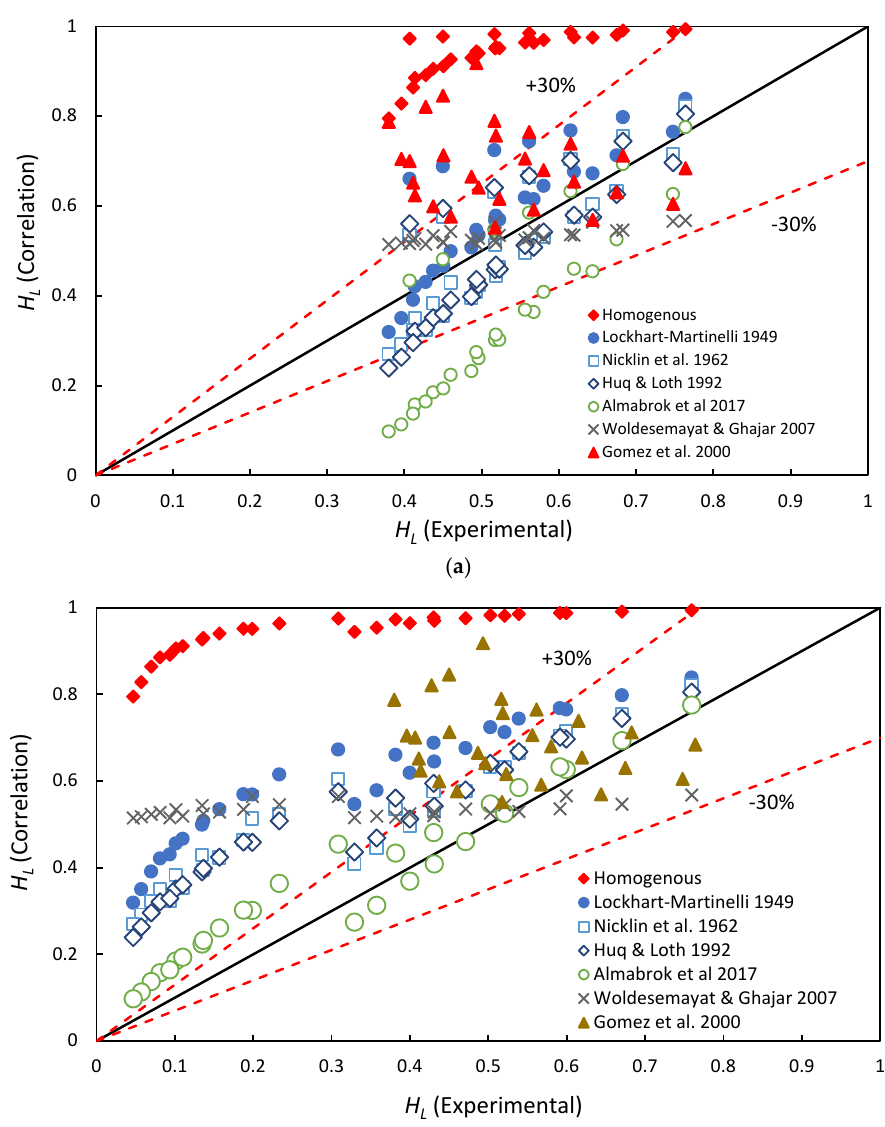
Figure 8. Comparison of predictions by various correlations and experimental H L for ( a ) flowline ( b ) riser base injection [13,14,16,17,20,34].